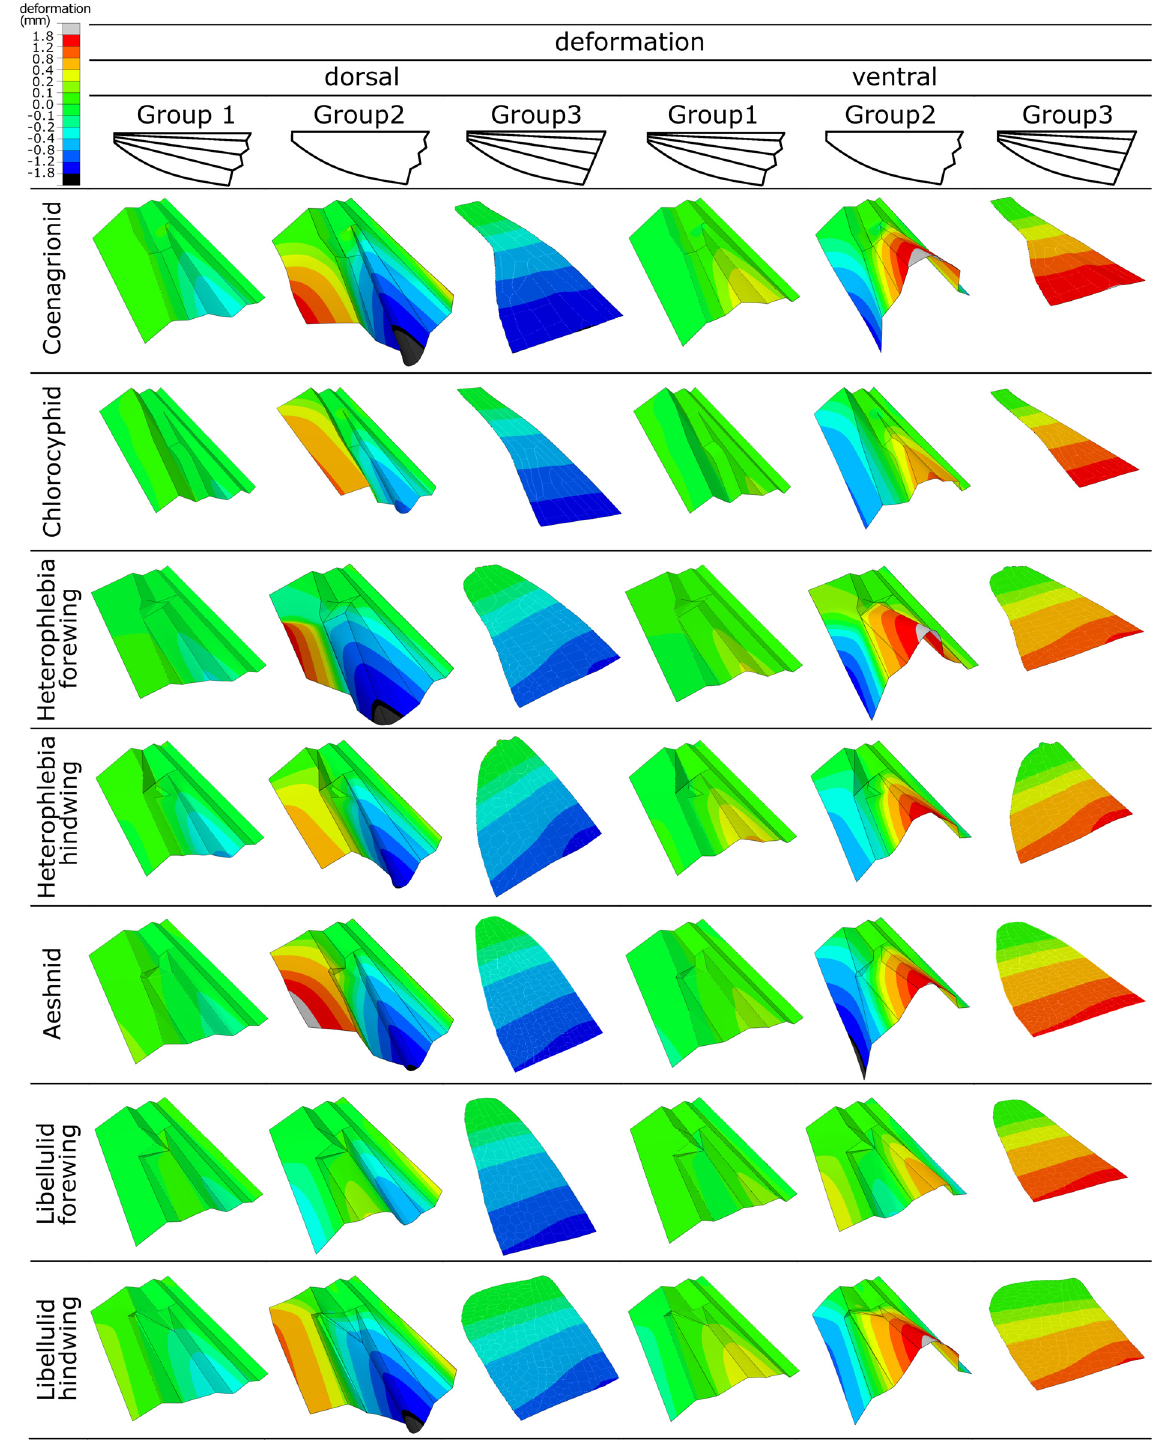
Fig 3. Deformation pattern of the models of the three model groups. The wing deformation has been shown under both dorsal and ventral loadings. The removal of the basal veins from the models of Group 1 led to the significantly larger deformations in the models of Group 2. However, the corresponding models from these two groups show a relatively similar deformation pattern. The models from Group 3 (models without basal complex, but containing basal veins) experience much larger deformation than the models of Group 1. The totally different types of the deformation in the corresponding models from these groups indicate the crucial influence of the basal complex on the deformation pattern of Odonata wings.